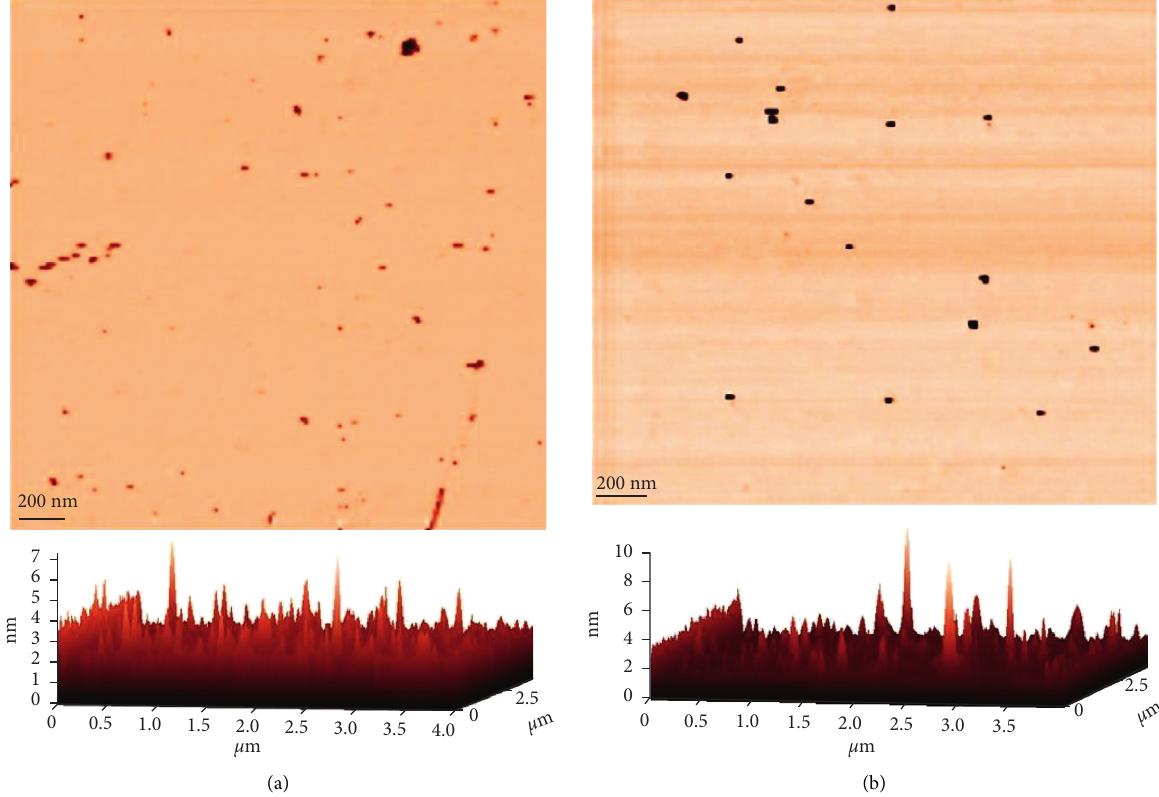
Figure 3: AFM image of P4 (a), phase image (top), and height image (bottom); AFM image of P4 ′ (b) phase image (top) and height image (bottom).